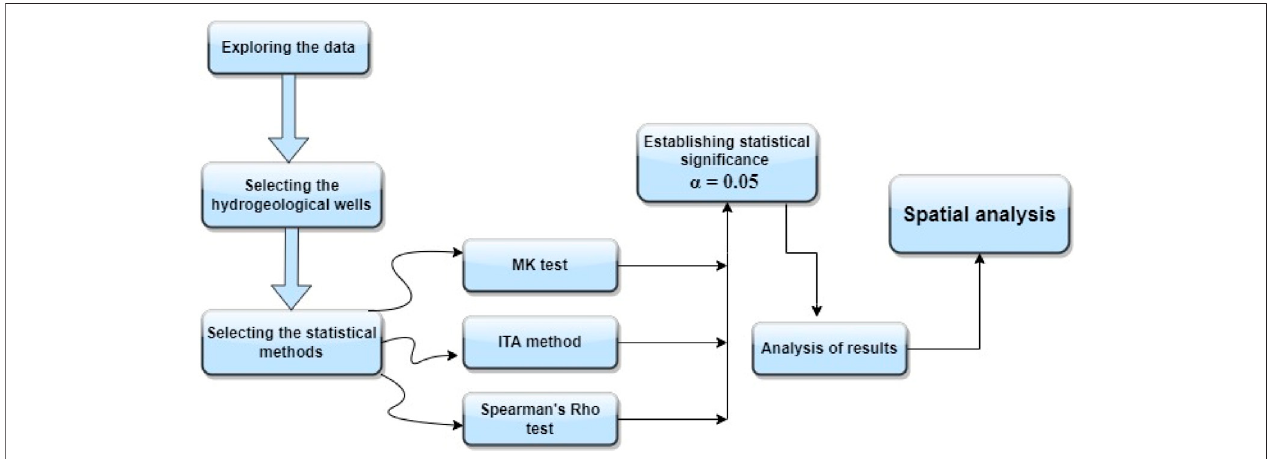
FIGURE 2 | Flow chart of statistical analysis